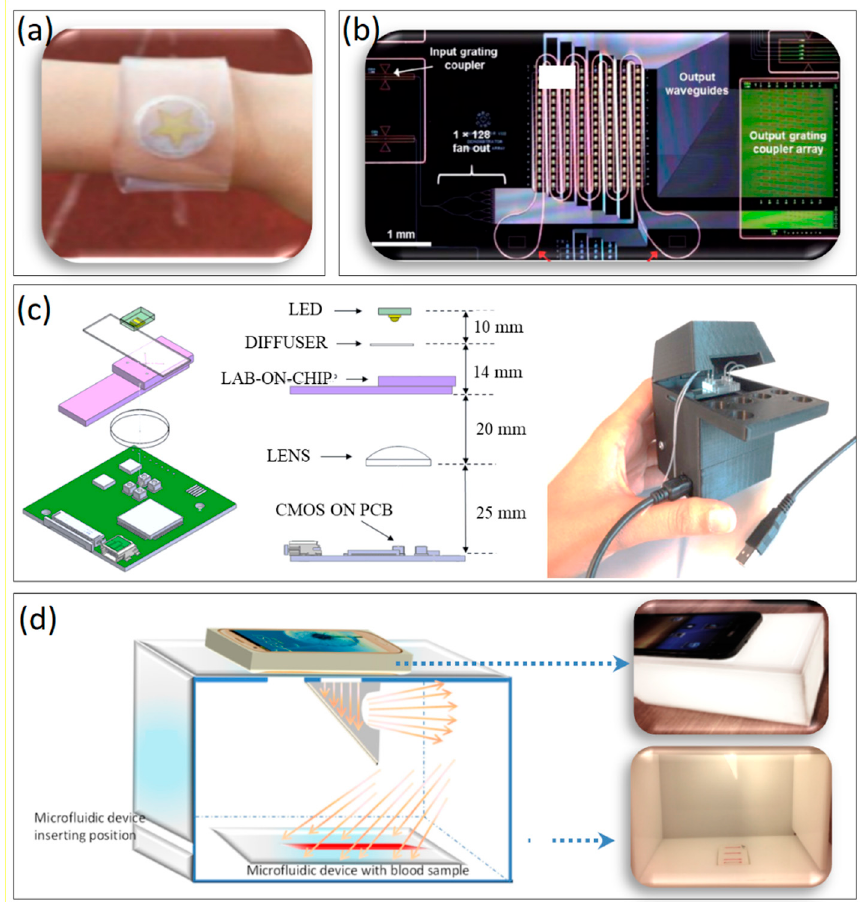
Figure 6. ( a ) LSPR wearable colorimetric sensor to detect humidity. Adapted with the permission from Ref. [177], Copyright (2017), John Wiley and Sons. ( b ) Microscope image of a sensor made to acquire 128 real-time optical sensor outputs simultaneously. Adapted with the permission from Ref. [183]. Copyright (2019), Elsevier. ( c ) From left to right: schematic representation of the T-LSPR set-up, side view with relative distances between components, and final complete device. Adapted with the permission from Ref. [187]. Copyright (2015), American Chemical Society. ( d ) Schematic representation of the microfluidic device and its realization for colorimetric analysis of blood hematocrit. Adapted with the permission from Ref. [191]. Copyright (2017), Elsevier. The presented device overcomes some of these limitations and problems. In fact, for one thing, the plasmon shift is not monitored, but the plasmon field excites a fluorescence signal of the dyes bound to the analyte, improving the detection sensitivity up to 10 times. To maximize the fabrication of metal nanostructures, a printed 4 ″ nickel wafer was fab- ricated by electroplating. The process is well described in [192]. The metal structures that allow for the exploiting of the LSPR phenomenon are gold nanopores, and the fluoro- phore Alexa-Fluor 647 was used. In this particular case, immobilization of the anti-PSA antibody led to revealing the presence of PSA. The technique used for immobilization is dual polarization interferometry. To realize the POC system, a microfluidic chip was in- serted into a system of micro-pumps controlling the flow. This POC system, unlike others, is very compact, so much so that a smartphone camera can be used as a CMOS imaging IC. Kim et al. presented a smartphone-based sensor for colorimetric analysis of hemato- crit with an LOD of 0.1% [191]. In this case, the smartphone camera catches images of the blood present in the microchannel, and the resulting data are analyzed using a dedicated app. Specifically, the blood was diluted with plasma to have different hematocrit con- centrations and then loaded into the microchannel with a PDMS micropump. Blood im- ages were processed by the grey-scale-valuation relative to each pixel, which increases as